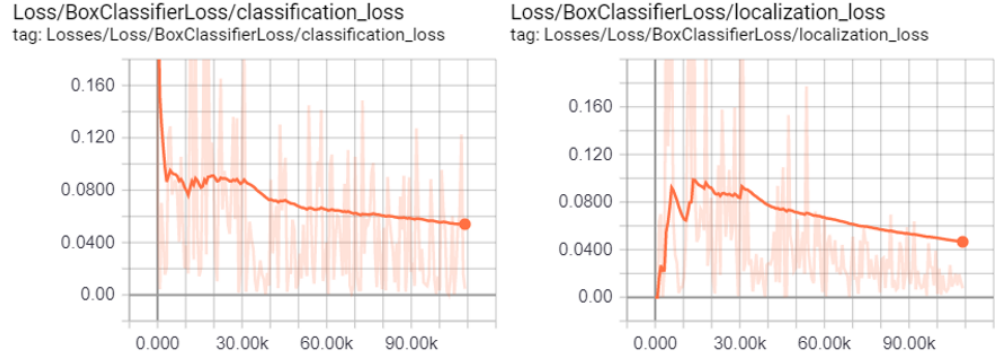
Figure 7. Changes of classification loss and localization loss (with and without smoothing) during the training process (stopped after 11,000